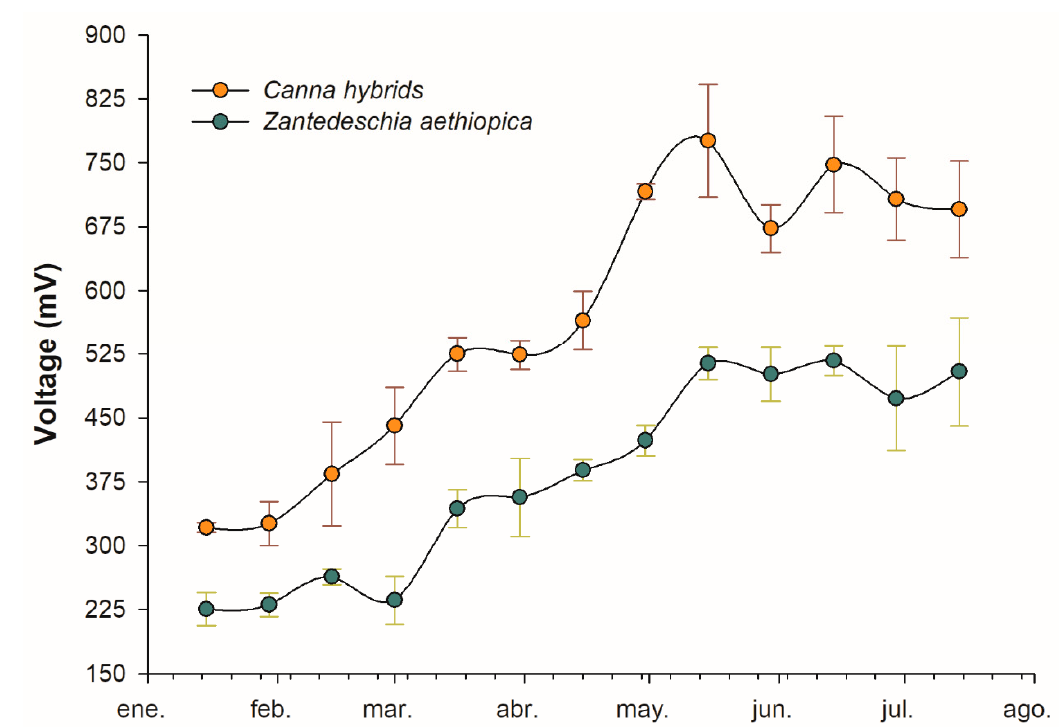
Figure 5. Comparison of the voltage (mV) generated in VPS-CW systems using Canna hybrids and Z. aethiopica during 8 months of retention.